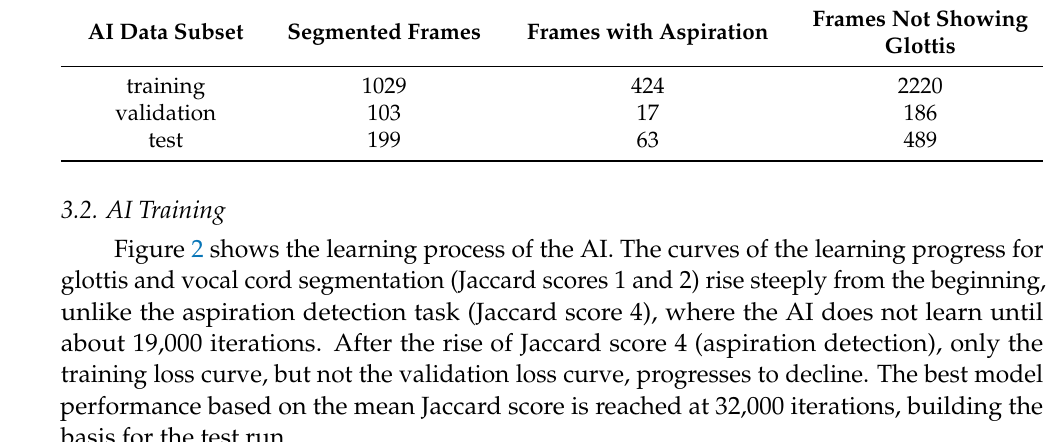
Table 1. Distribution of annotated frames across the different data sets.